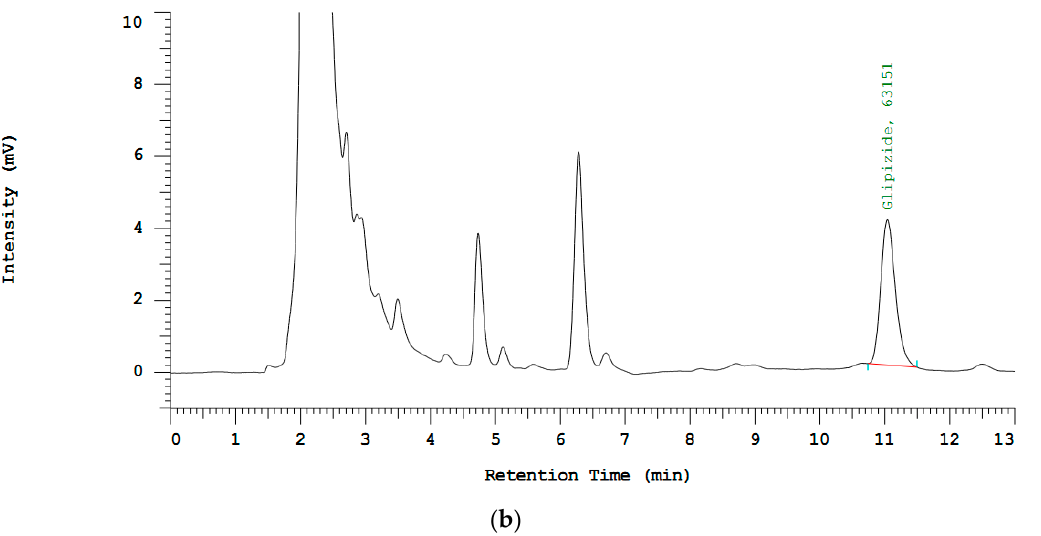
Figure 1. HPLC chromatogram of blank plasma ( a ) and glipizide (retention time 11.07 min) in plasma ( b ) using mobile phase KH 2 PO 4 , pH 4.25, acetonitrile (57.43%), and flow rate 1 mL/min. Table 1. System suitability test (SST) results of glipizide in spike plasma. Parameters Result Acceptance